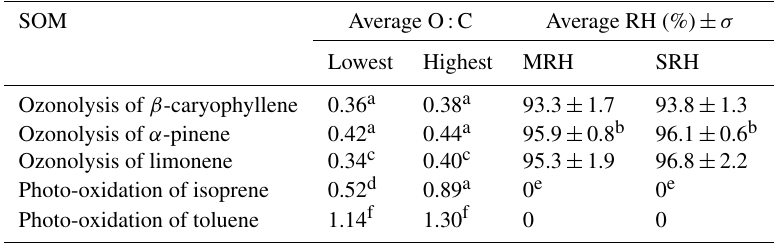
Table 3. Summary of the LLPS results as well as the average oxygen-to-carbon atomic ratios (O:C) of the studied SOM particles. The standard deviation ( σ) of the separation relative humidity (SRH) and mixing relative humidity (MRH) is derived from several cycles of RH for different SOM mass concentrations. SRH = 0 and MRH = 0 indicate phase separation was not observed. The average O:C values for SOM from toluene photo-oxidation are based on the current study (Sect. 2.1). The average O:C values for the other SOM are taken from the literature. Since the average O:C can depend on oxidant time and oxidation conditions, we chose literature data that were closest to the experimental conditions used in the LLPS studies (Supplement, Sect. S1 and Table S1).